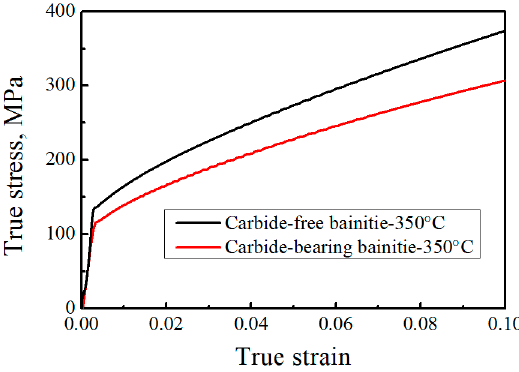
Figure 7. Supercooled austenite strength curve at 350 °C isothermal temperature.